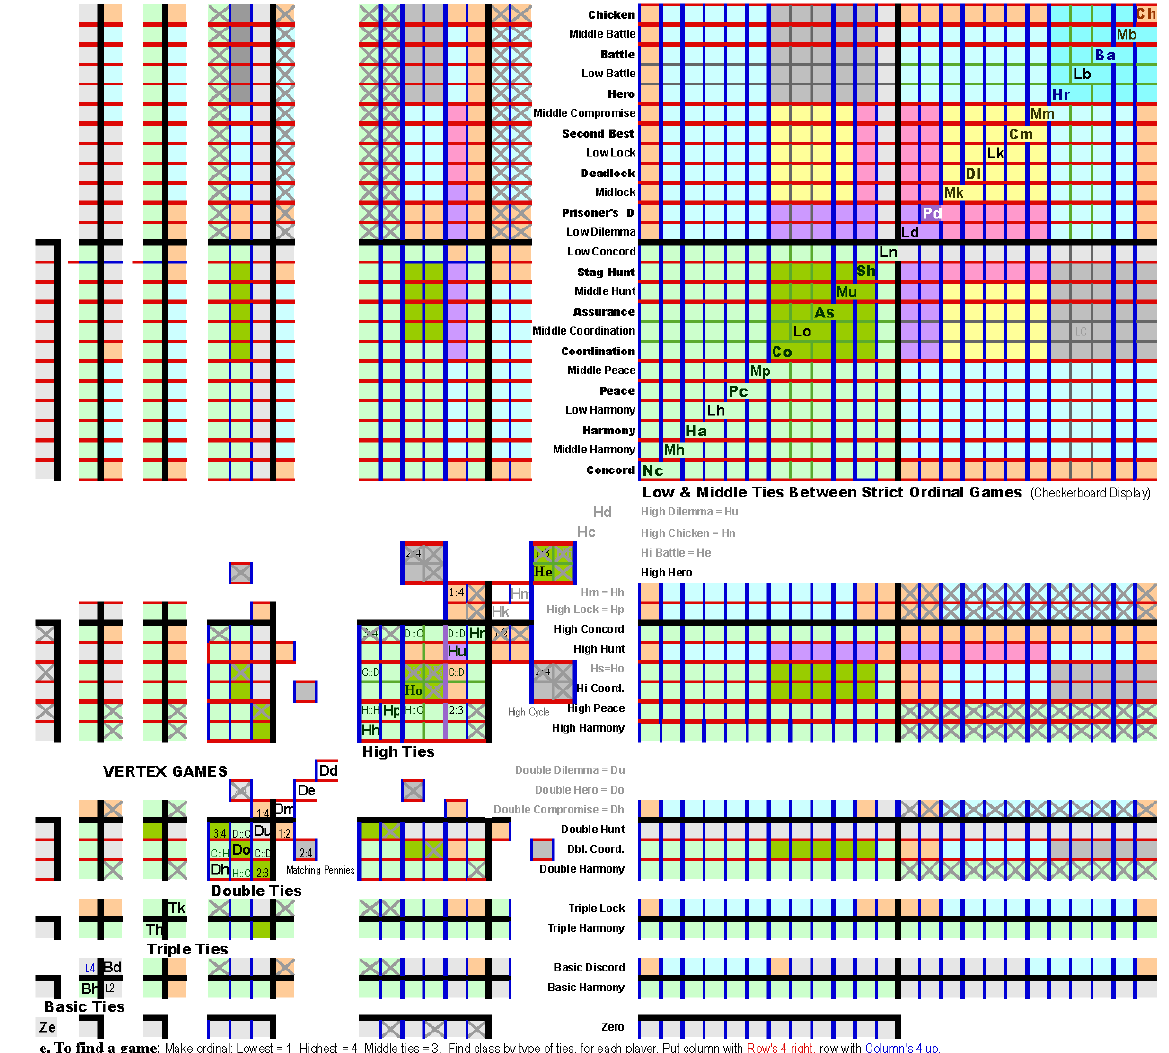
Figure 3. The complete set of 2 × 2 ordinal games. Symmetric games form the diagonal axis in this schematic diagram of an expanded topology of 2 × 2 games that includes games with ties. Games are linked by half-swaps that make or break ties. Games with low and middle ties games are interlaced with strict games in a checkerboard pattern